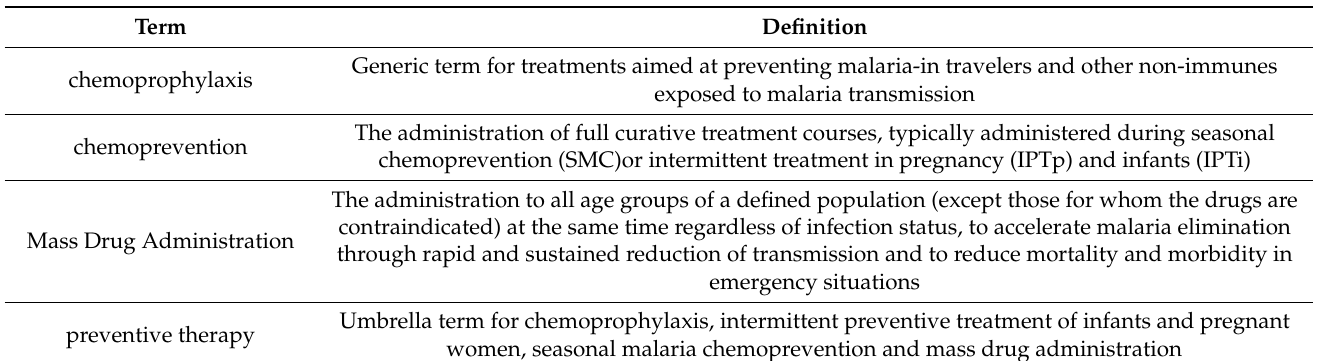
Table 2. Definitions of preventive medications for malaria [4–6] for the last